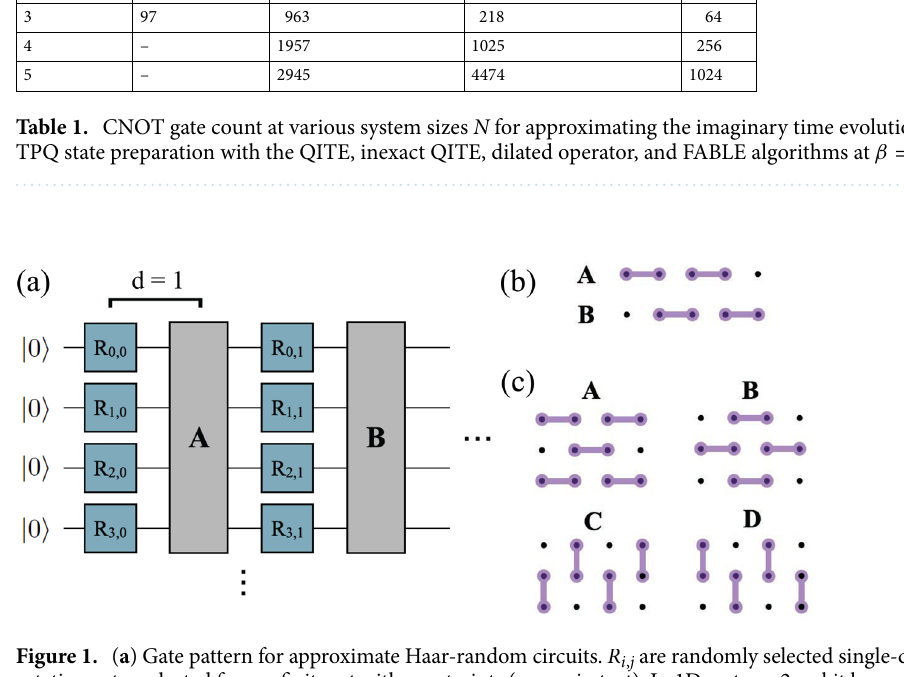
Figure 1. ( a ) Gate pattern for approximate Haar-random circuits. R i , j are randomly selected single-qubit rotation gates selected from a finite set with constraints (see main text). In 1D systems 2-qubit layers follow the pattern ABAB... with individual layer patterns specified in ( b ), while in 2D systems, 2-qubit layers follow the pattern ABCDABCD... , with individual layer patterns specified in ( c